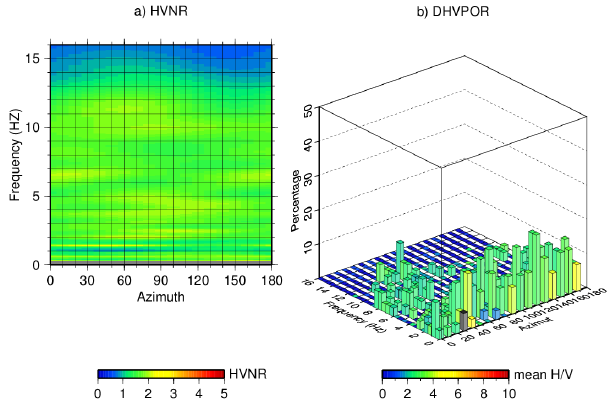
Fig. 7. Results of noise measurements at site T7 (Ischio landslide): (a) mean HVNR diagram; (b) DHVPOR histogram. Fig. 7 - Results of noise measurements at sites T7 (Ischio landslide): a) mean HVNR diagram; b) 3 DHVPOR histogram. 4